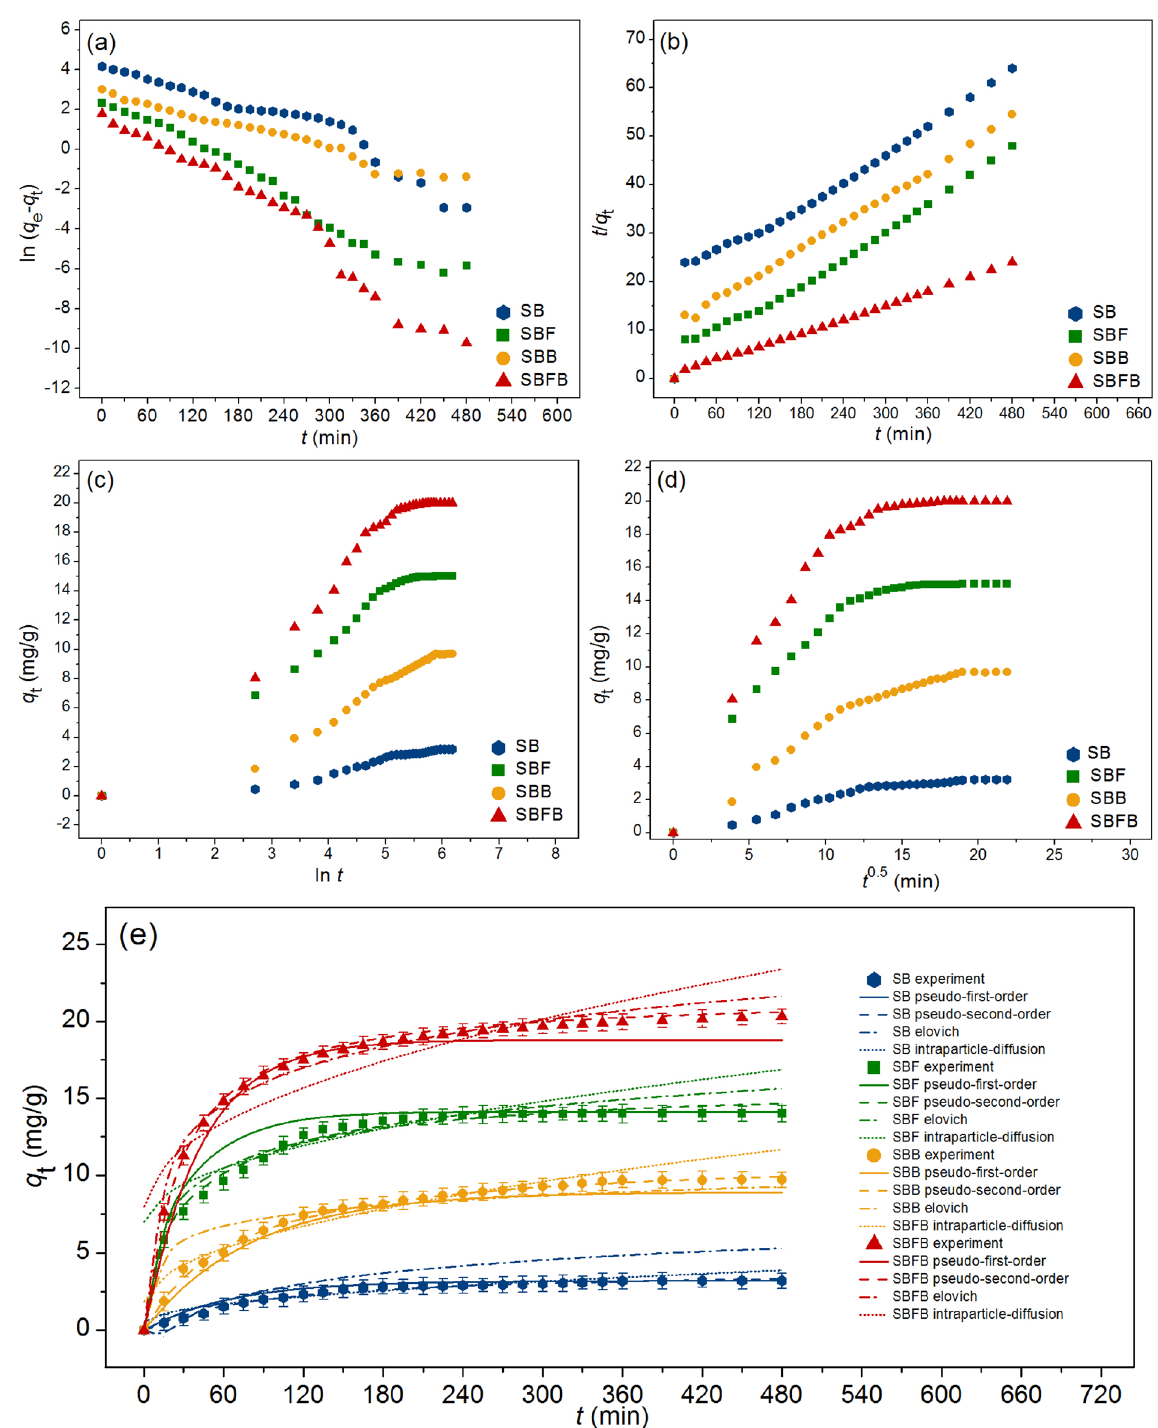
Figure 8. Graphs of ( a ) linear pseudo-first-order, ( b ) linear pseudo-second-order, ( c ) linear elovich model ( d ) linear intraparticle diffusion, and ( e ) nonlinear kinetic models of sugarcane bagasse powder (SB), sugarcane bagasse powder doped iron(III) oxide-hydroxide (SBF), sugarcane bagasse powder beads (SBB), and sugarcane bagasse powder doped iron(III) oxide-hydroxide beads (SBFB) for lead